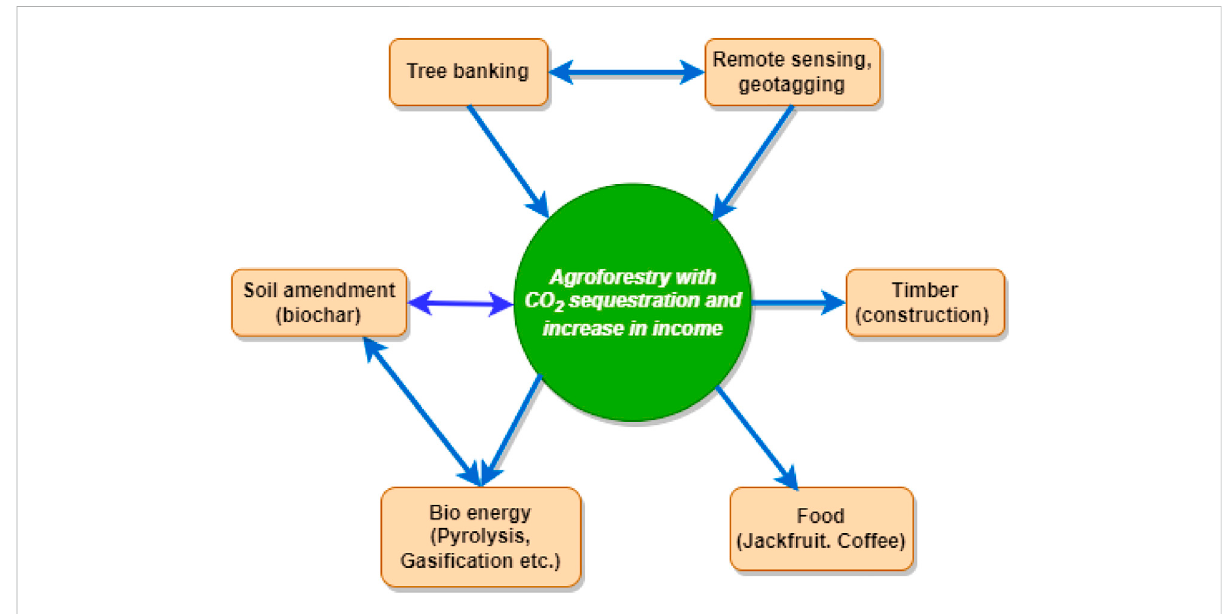
FIGURE 5 Mapping of the possible science and technology interventions for CO 2-eq sequestration and revenue generation in